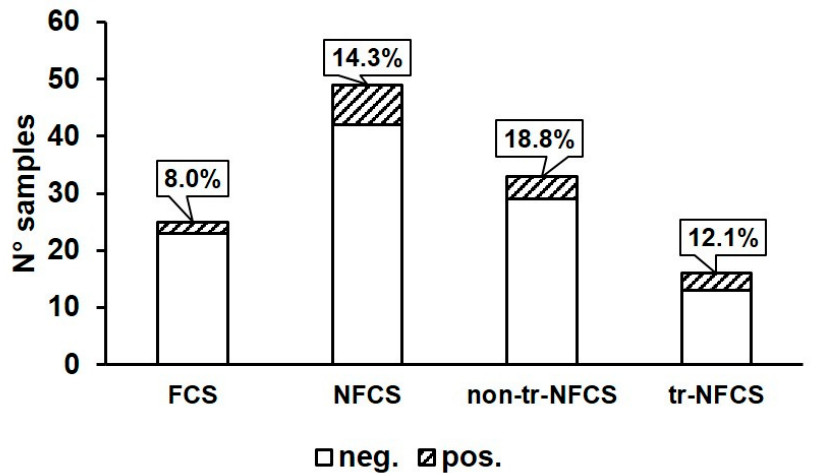
Figure 1. B. cereus detection rate (in percentage) in samples obtained from food contact surfaces (FCS) and non-food contact surfaces (NFCS). NFCS samples were also classified as total NFCS (NFCS), transfer-non food contact surfaces (tr-NFCS), and non-transfer-non food contact surfaces (non-tr-NFCS). Neg: samples negative for the presence of B. cereus ; Pos: samples positive for the presence of B. cereus .